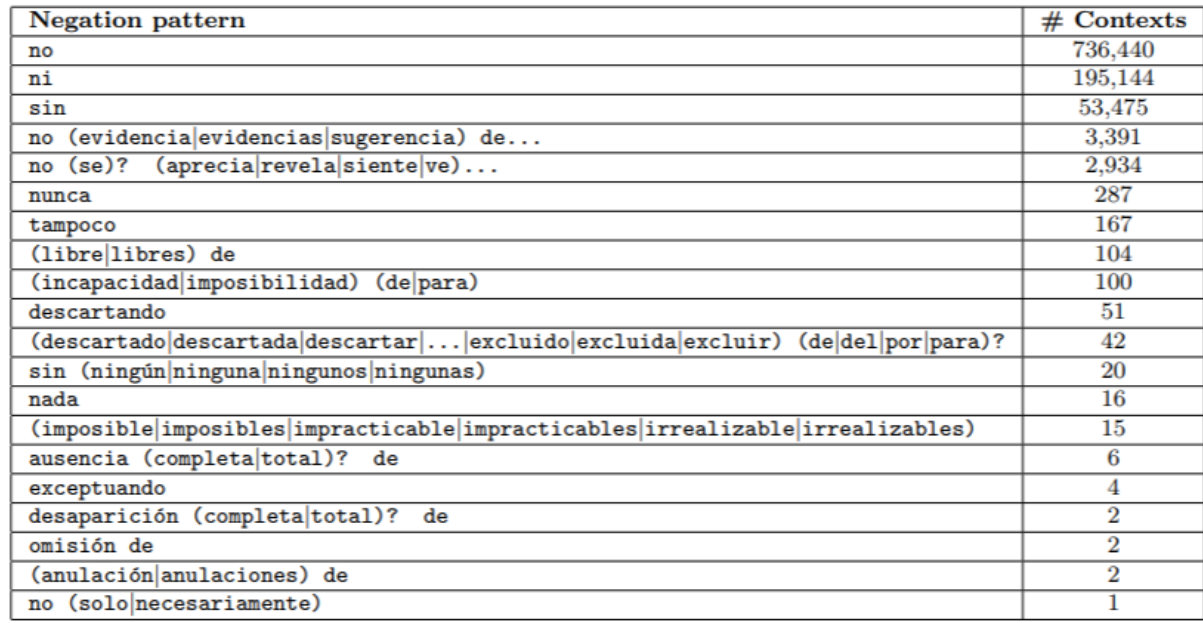
as “nadie” (nobody) and “negative” (negative), which do not appear in the data set. Figure 3. Statistics of the set of negation patterns